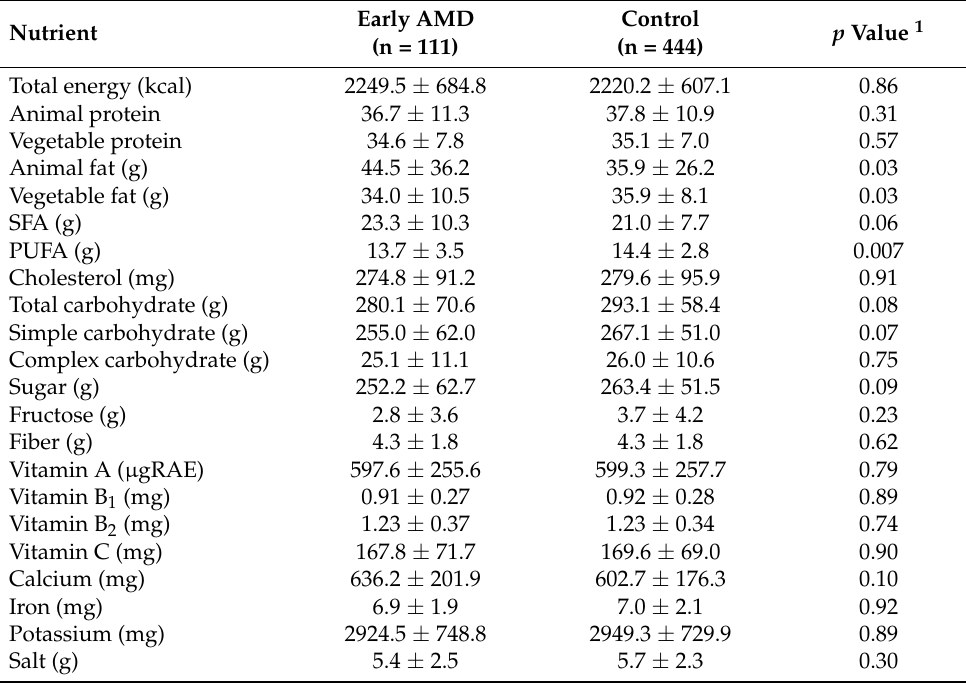
Table 2. Daily energy-adjusted nutrient intake of control and early age-related macular degeneration